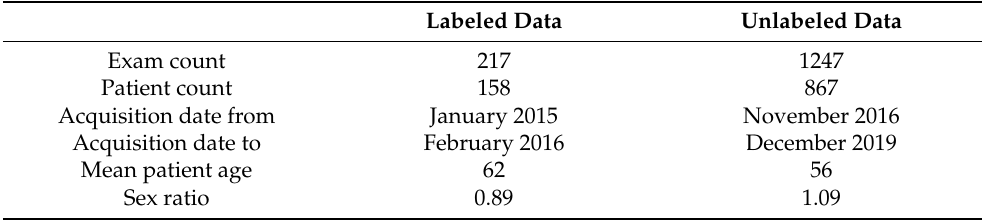
Table 1. Labeled and unlabeled data